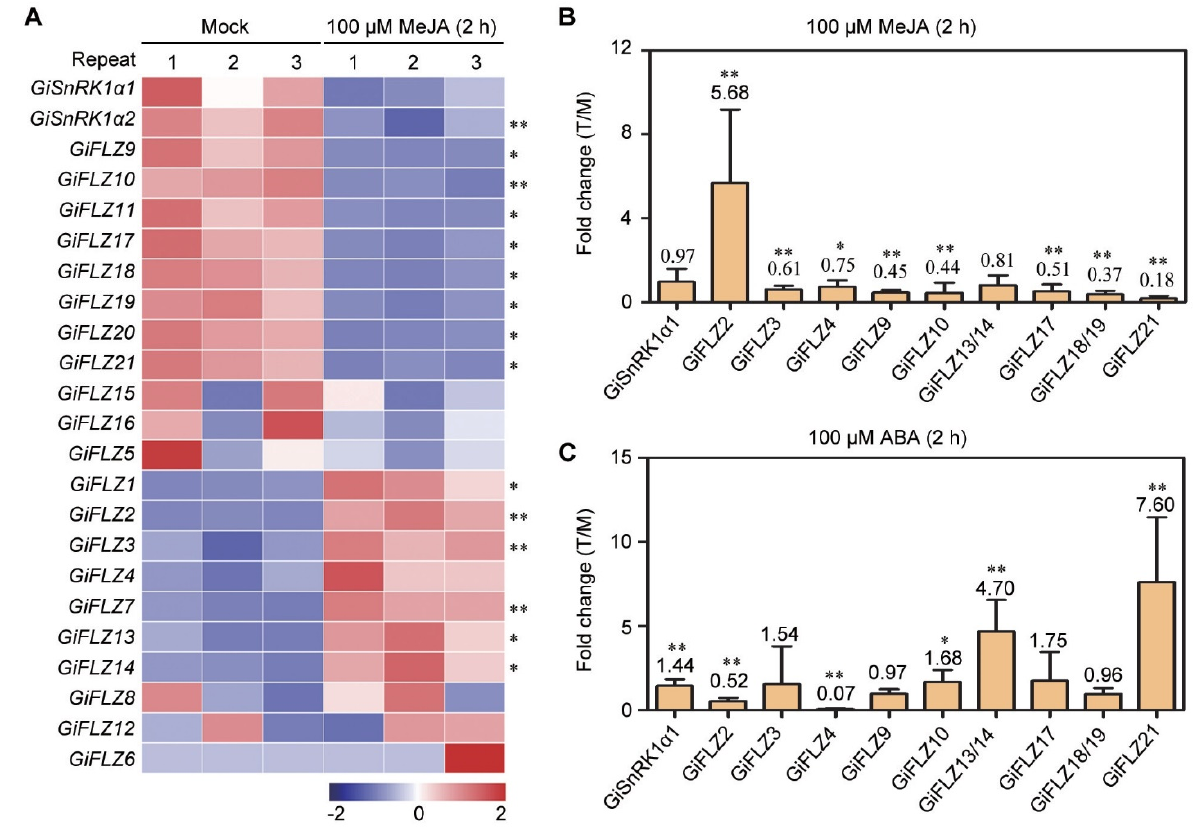
Figure 5. Expression pattern of GiSnRK1 α and GiFLZ genes in response to MeJA and ABA treatment. ( A ) Heat map of the gene expression of GiSnRK1 α and GiFLZ in hairy roots upon 100 μ M MeJA treatment. These expression data were normalized by taking log2 of FPKM and are shown from low (blue) to high (red) for each gene. ( B , C ) qRT ‐ PCR assay showing the expression of selected GiSnRK1 α and GiFLZ genes in roots of 5 ‐ day ‐ old seedlings exposed to 100 μ M MeJA ( B ) or 100 μ M ABA ( C ) treatment for 2 h. The fold change of treatment (T) to mock (M) are presented as mean ± SD ( n = 9), and the data on the graph indicate the ratios. *, p < 0.05; **, p < 0.01—determined by Student’s t ‐ test.